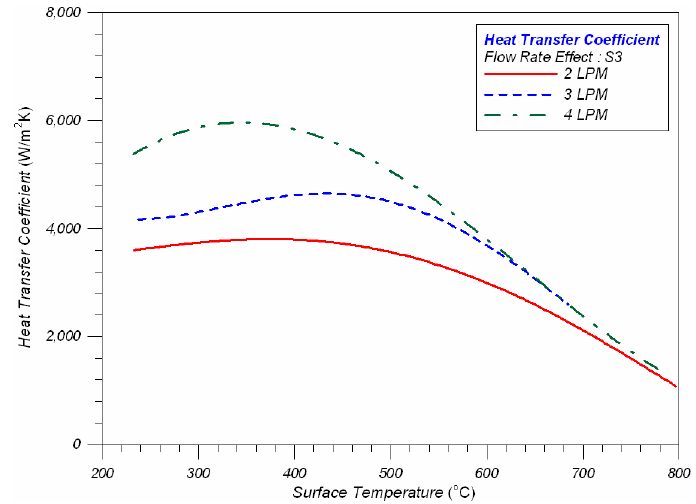
Fig. 7 Heat transfer coefficient at